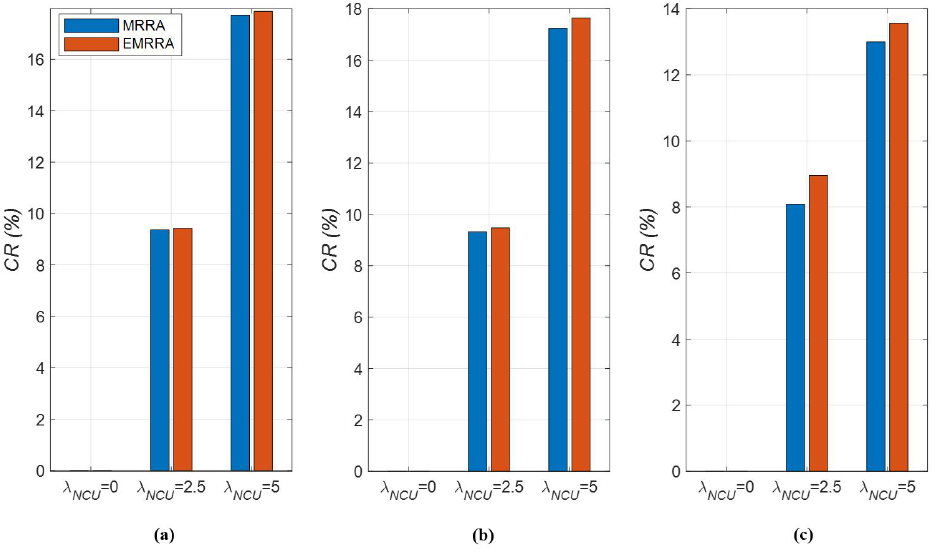
Figure 13. The collision rates of EMRRA and MRRA with respect to λ 10, K = 50; ( b ) N CU = 25, K = 50; ( c ) N CU = 50; K =